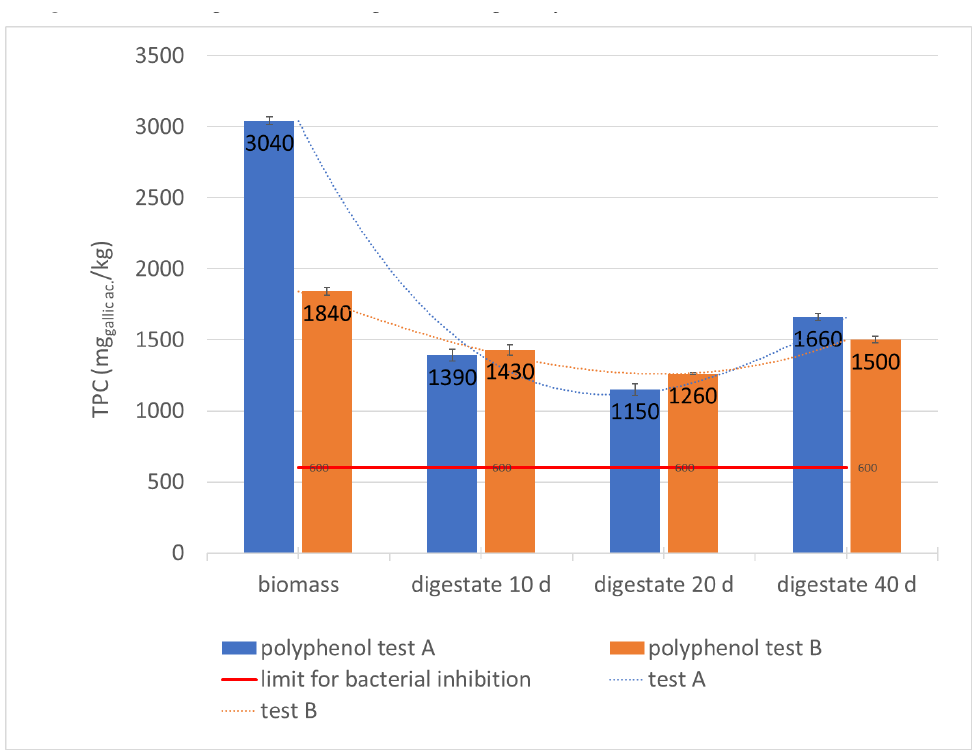
Figure 6. Monitoring of TVS in the digesters during the hydraulic retention time.